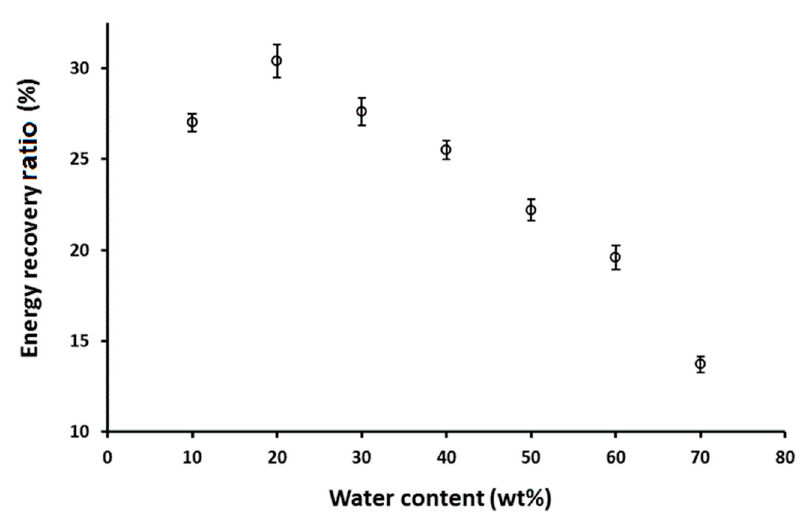
Figure 6. Energy recovery ratio (in %) as a function of tap water content (in wt%).